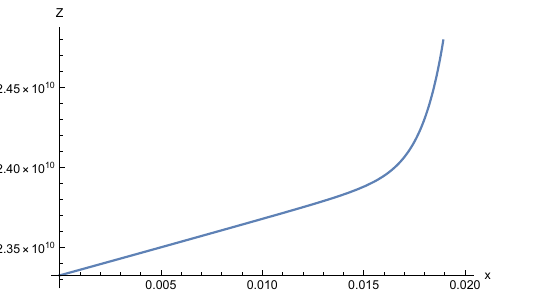
Figure 4. Plot of Z ( x ) . Here, x = β / R 1 , R 0 = 1, R 1 = 1000, G = m = M = 1.